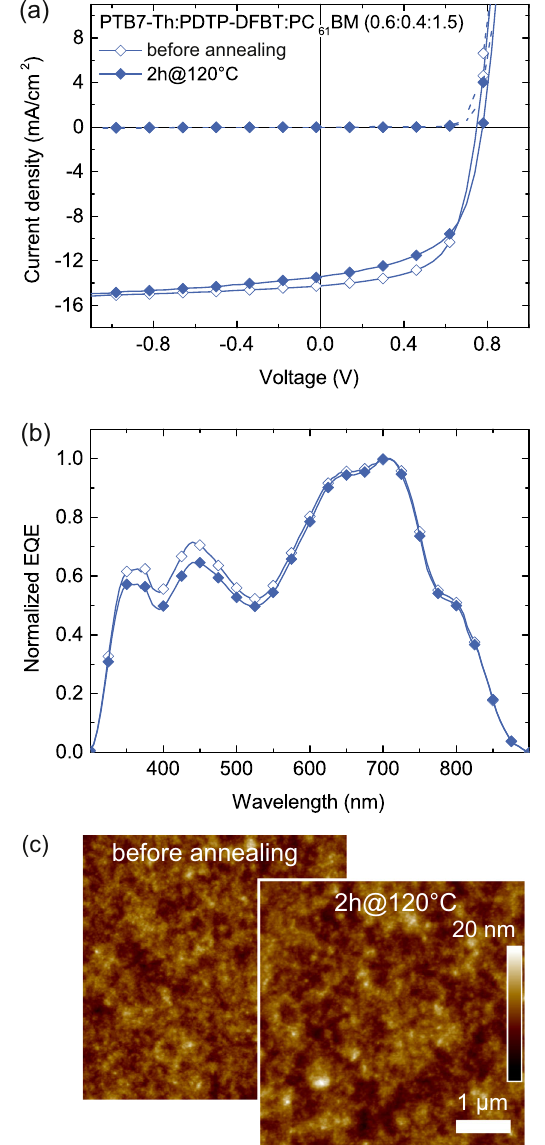
Fig. 4 a Typical J - V curves of PTB7-Th:PDTP – DFBT:PC 61 BM (0.6:0.4:1.5) solar cells under AM1.5 irradiation (solid lines) and in the dark (dashed lines) before and after thermal annealing (120 °C, 2 h), demonstrating excellent thermal stability of the ternary bulk- heterojunction. b The (normalized) corresponding external quan- tum ef fi ciencies show only minor deterioration in the fullerene absorption regime. c Typical AFM images of PTB7-Th:PDTP – DFBT: PC 61 BM (0.6:0.4:1.5) thin- fi lms before (back) and after annealing (front), qualitatively showing no change in surface topography